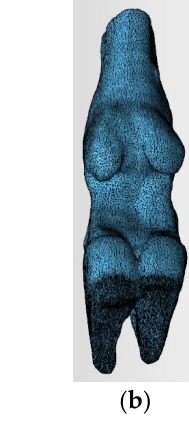
Figure 1. Test goat with goat-foot model: ( a ) Test goat; ( b ) 3D-model of goat foot. After the 3D-model bone-density analysis, it was found that the hind legs of the goats produced more thrust during movement. In accordance with the principle of symmetry, there was no difference between the left and right hind foot of the selected goat, and the external hoof-flap of the goat was more robust than the internal hoof-flap. In the research, the external hoof-flap of the left hindfoot was selected as the bionic prototype, as shown in Figure 2a. CATIA (Dassault, Paris, France) software was used to extract the point-cloud data of the left hindfoot, and the chordal deviation method was adopted to simplify